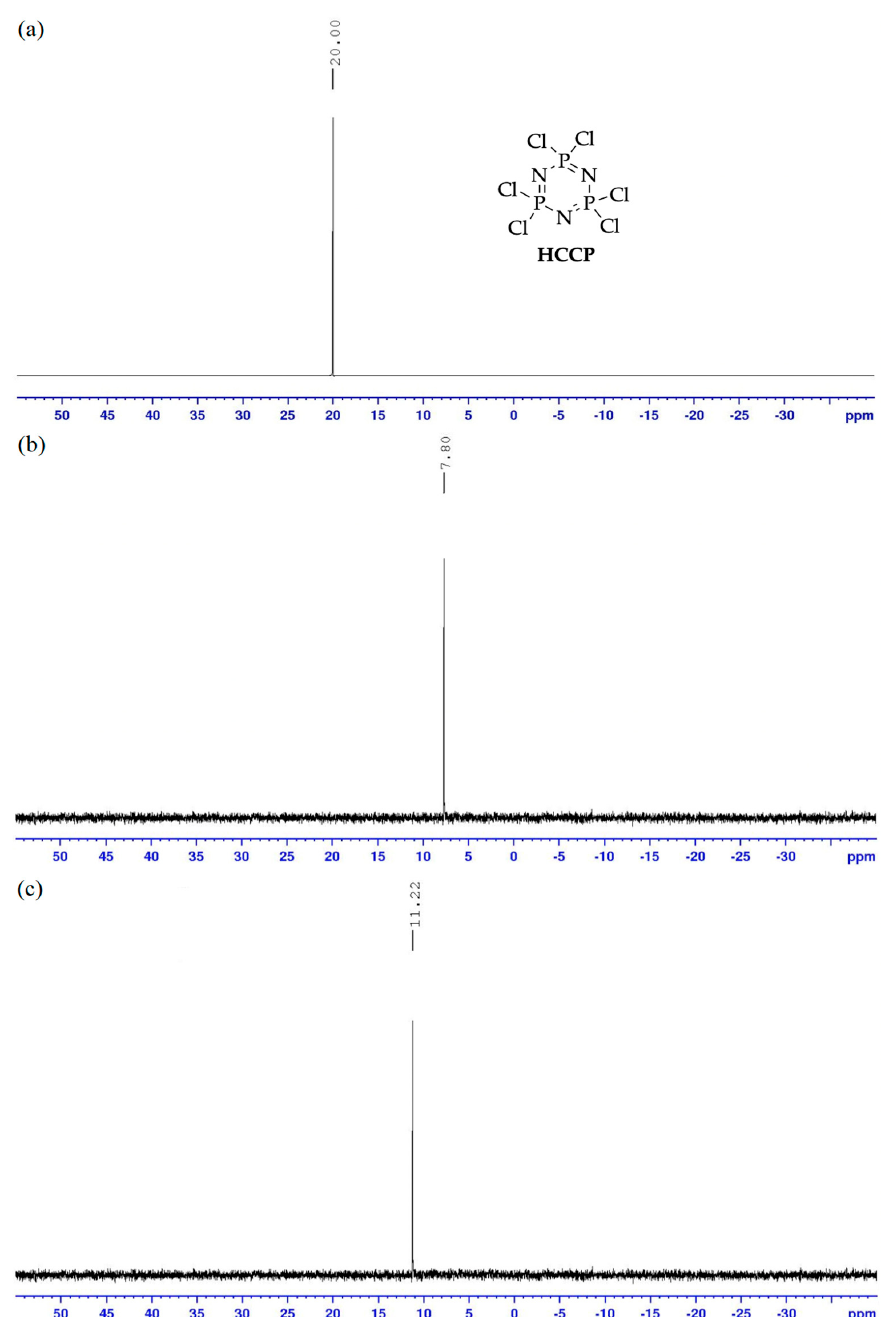
Figure 10. 31 P-NMR spectrum of ( a ) HCCP, ( b ) compound 6e , and ( c ) compound